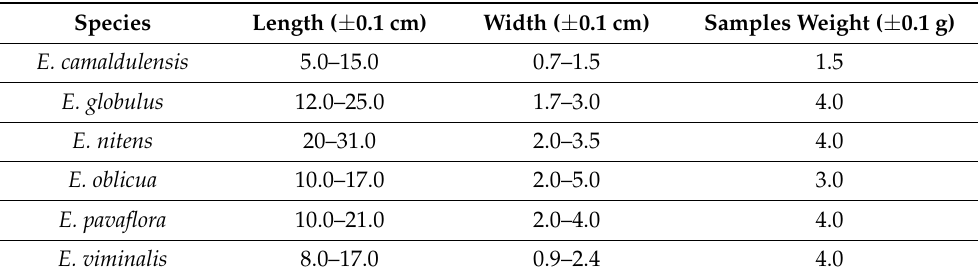
Table 1. Leaf size of the six species studied and weights of the